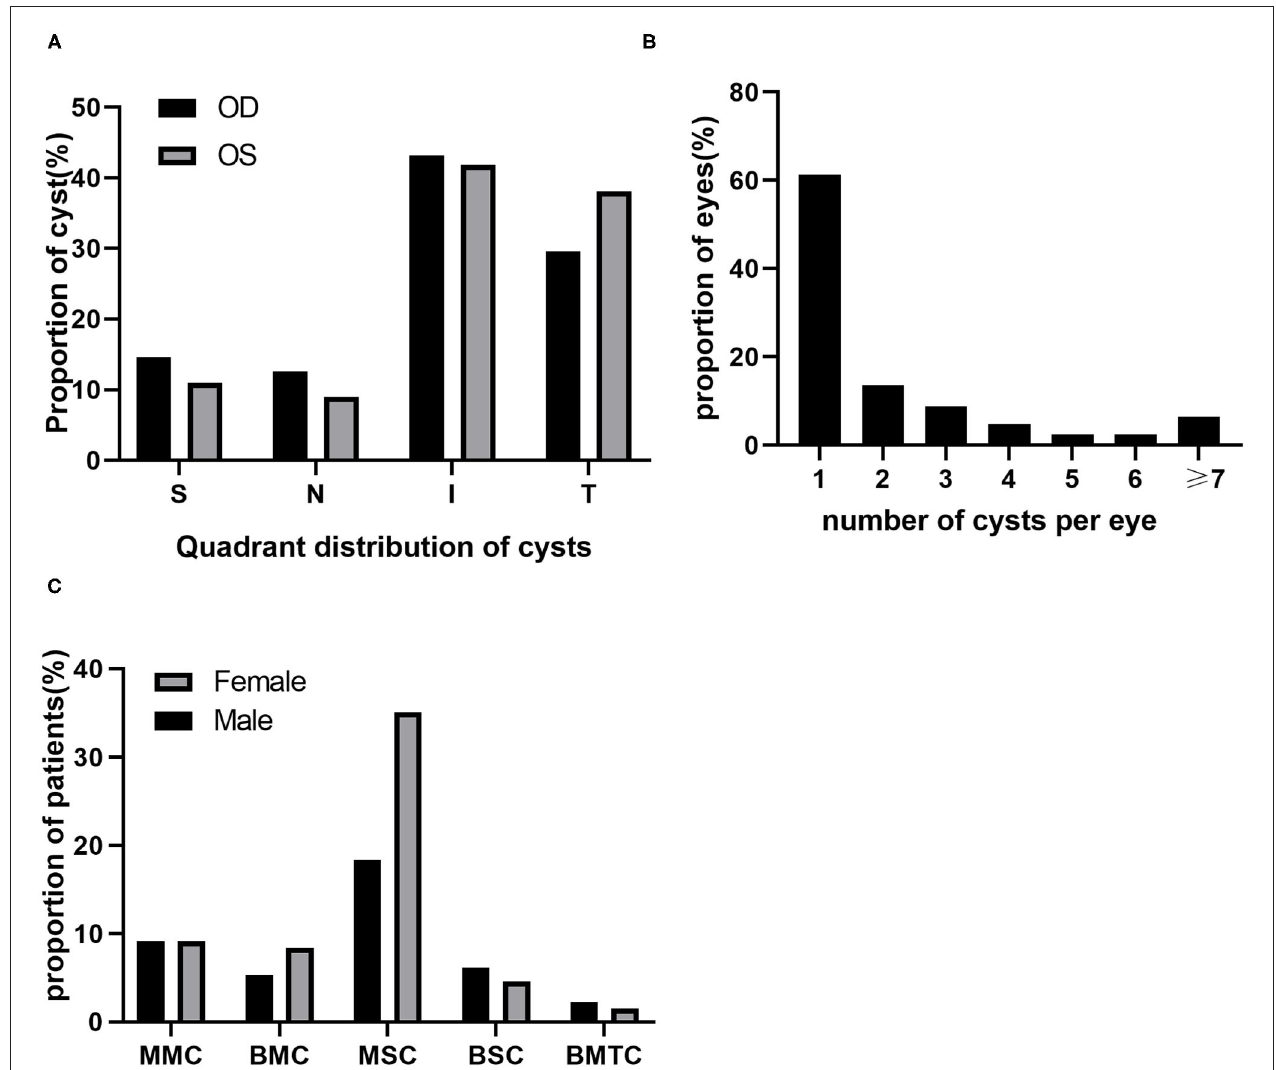
FIGURE 2 | Distribution of cysts. (A) Quadrant distribution of cysts; N, nasal; I, inferior; T, temporal; S, superior. (B) Number of cysts per eye. (C) Type of cysts; MMC, monocular multiple cysts; BMC, bilateral multiple cysts; MSC, monocular single cysts; BSC, bilateral single cysts; BMTC, bilateral mix type cysts.